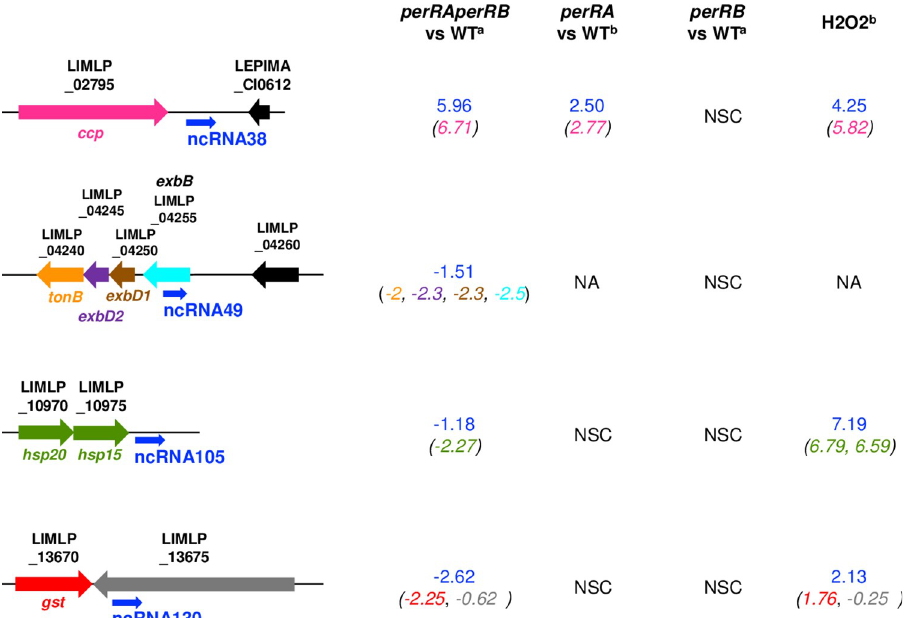
Fig 10. Non-coding RNAs expression in the double perRAperRB mutant. Differential expression of selected ncRNAs (LepncRNA38, 49, 105, and 130) in the perRAperRB mutant (determined in this study) ( a ) was compared to those in the single perRA mutant, as determined by Zavala-Alvarado et al . [19] ( b ), in the single perRB mutant (determined by this study) ( a ), and upon exposure to 1 mM H 2 O 2 for 1h00 as determined by Zavala-Alvarado et al . [19] ( b ). The location of the ncRNAs LepncRNA38, 49, 105, and 130 were represented schematically with the adjacent or overlapping ORFs. The values indicate the Log 2 FC of ncRNAs expression normalized with that in WT. The respective expression of these ORFs (Log 2 FC) are indicated into parenthesis with the same color as their representation in the cartoon. NSC, non-significantly changed; NA, non-applicable.